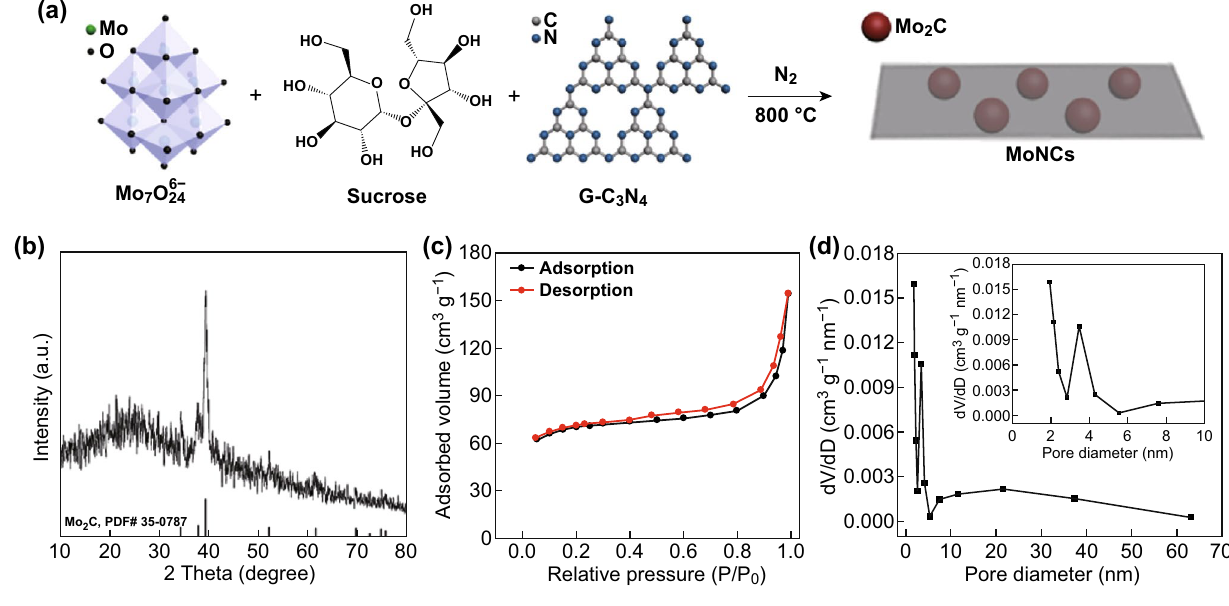
Fig. 2 a Illustration of the synthesis route, b XRD pattern, c nitrogen adsorption–desorption isotherms, and d the corresponding pore size distri- bution curves of